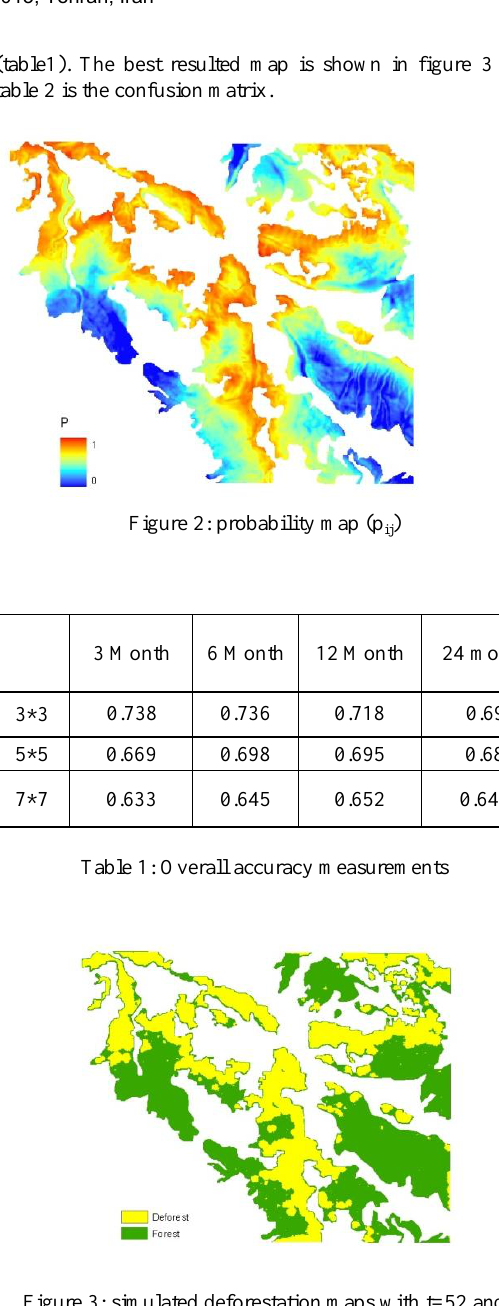
Figure 3: simulated deforestation maps with t=52 and Neighbourhood window: 3*3